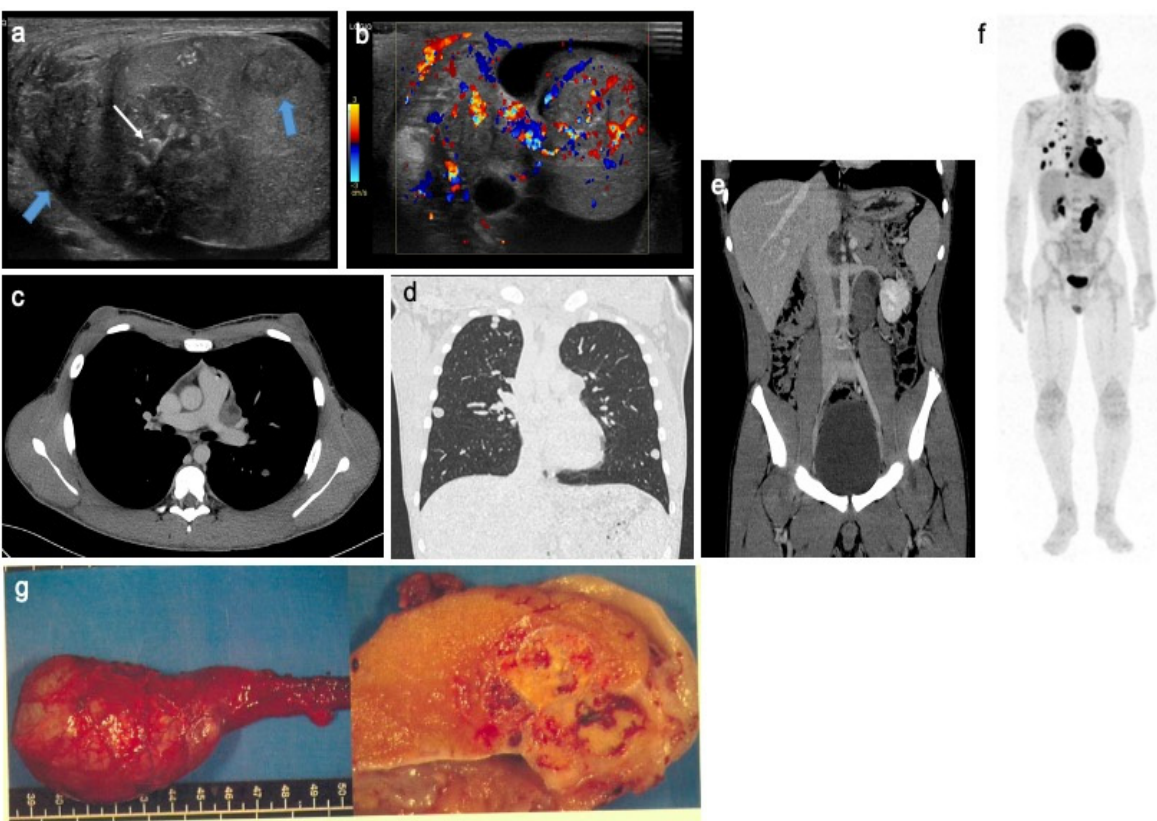
Figure 4. Mixed non-seminomatous malignant germ cell tumor in a 14-year-old boy with yolk-sac and choriocarcinoma components. Longitudinal gray-scale B mode ( a ) and transverse color Doppler ( b ) US of the testis. Contrast-enhanced CT on axial view of the mediastinum ( c ), coronal view of the lung ( d ) and coronal view of the abdomen and pelvis ( e ). Coronal view of 18 F-FDG PET ( f ). Images show several heterogeneous testicular lesions (blue arrow) containing micro calcifications (white arrow) and highly vascularized tissular portions with irregular distribution ( b ). CT scan demon- strates metastatic mediastinal and retroperitoneal lymph nodes and multiple lung metastases with high uptake on 18 F-FDG PET. ( g ) Macroscopic view with gross pathology section of the lesion after radical surgery. This adolescent presented a rapid increase in testicular volume and increased AFP and BHCG levels. US, ultrasonography; AFP, alpha-fetoprotein; BHCG, beta-human chorionic gon- adotrophin; 18 F-FDG PET, 18 F fluorodeoxyglucose positron emission tomography. Courtesy of Dr